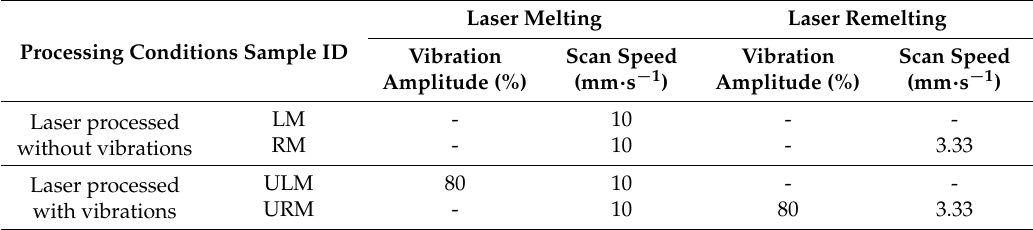
Table 1. Processing conditions used for laser surface cladding of 2024 aluminum alloy with